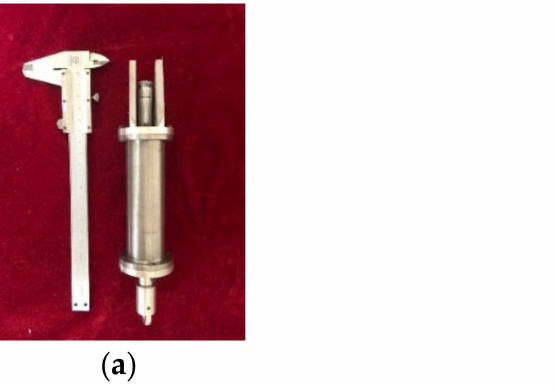
Figure 7. Prototype of the proposed MR damper. ( a ) Parts, ( b ) assembly.